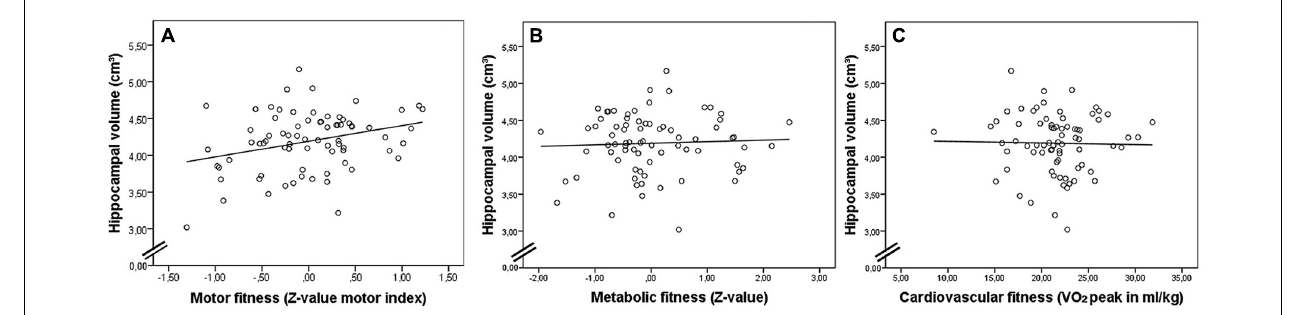
FIGURE 2 | Scatterplots showing sum of hippocampal volume of both hemispheres (in cm 3 ) in relationship with (A) motor fitness (significant), (B) metabolic fitness, and (C) cardiovascular fitness at t 1.